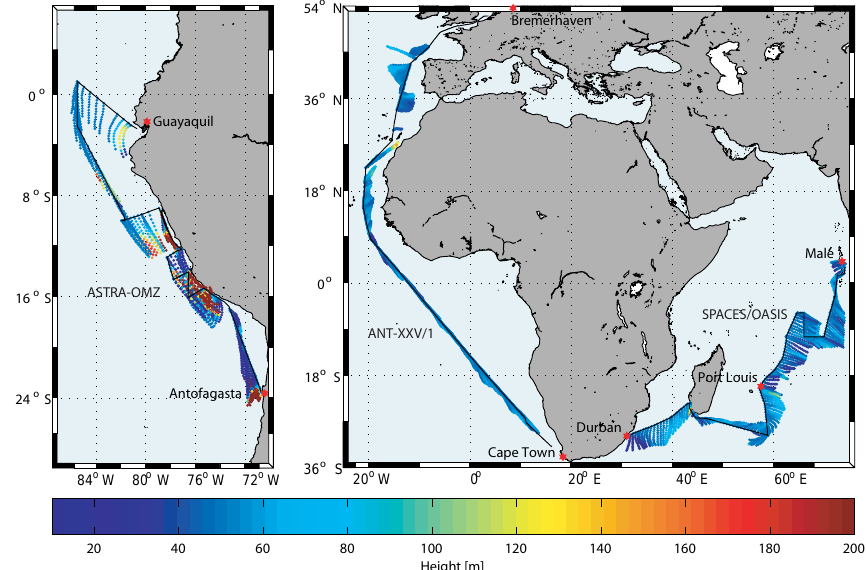
Figure 1. Cruise tracks (black) of ANT-XXV/1 (November 2008, eastern Atlantic Ocean), SPACES/OASIS (June–July 2014, Indian Ocean) and ASTRA-OMZ (October 2015, eastern Pacific Ocean). Air mass back trajectories calculated for 12h with a starting height of 50m using HYSPLIT are superimposed on the cruise track. Color coding indicates altitude above sea